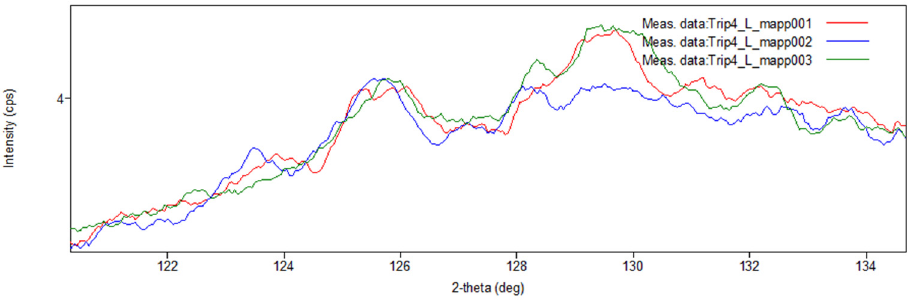
Figure 11. Ferrite peaks (211) measured at three points for the TRIP 4 sample after impact bending test.